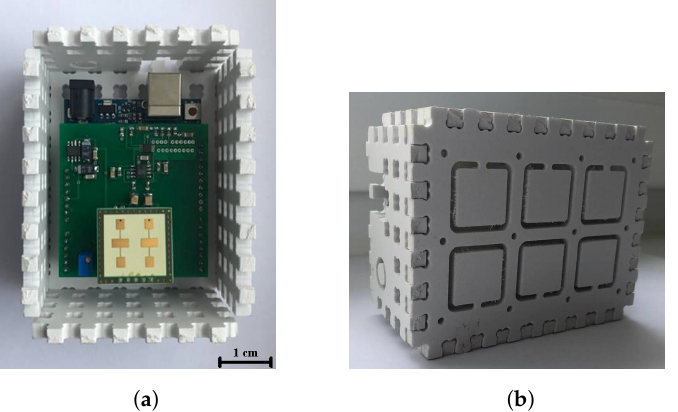
Figure 1. The bioradar prototype photos. ( a ) The front panel removed. ( b ) The bioradar